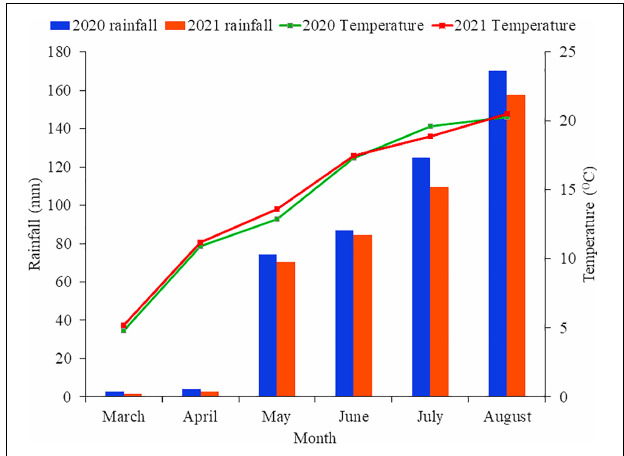
FIGURE 1 | The monthly mean rainfall and temperature during the growing seasons (2020 and 2021) at the experimental